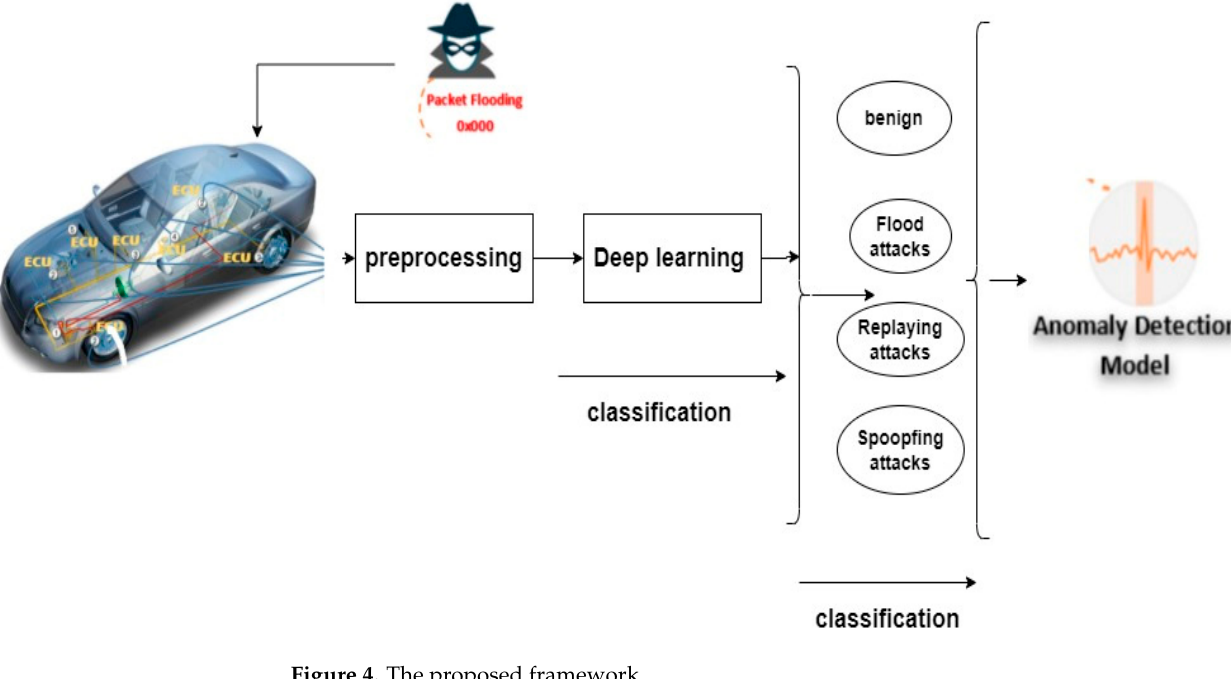
Figure 4. The proposed framework.